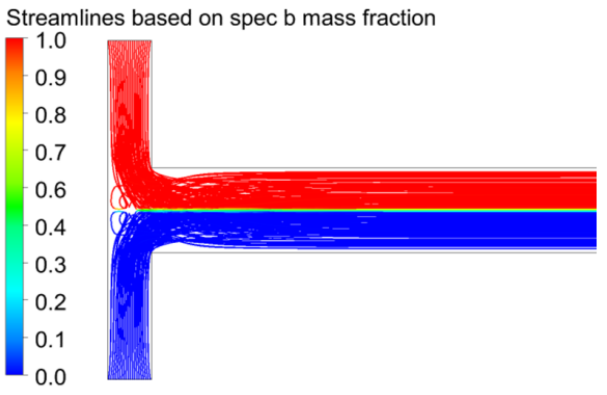
Figure 12. Streamlines of T-mixer from top view at Re =